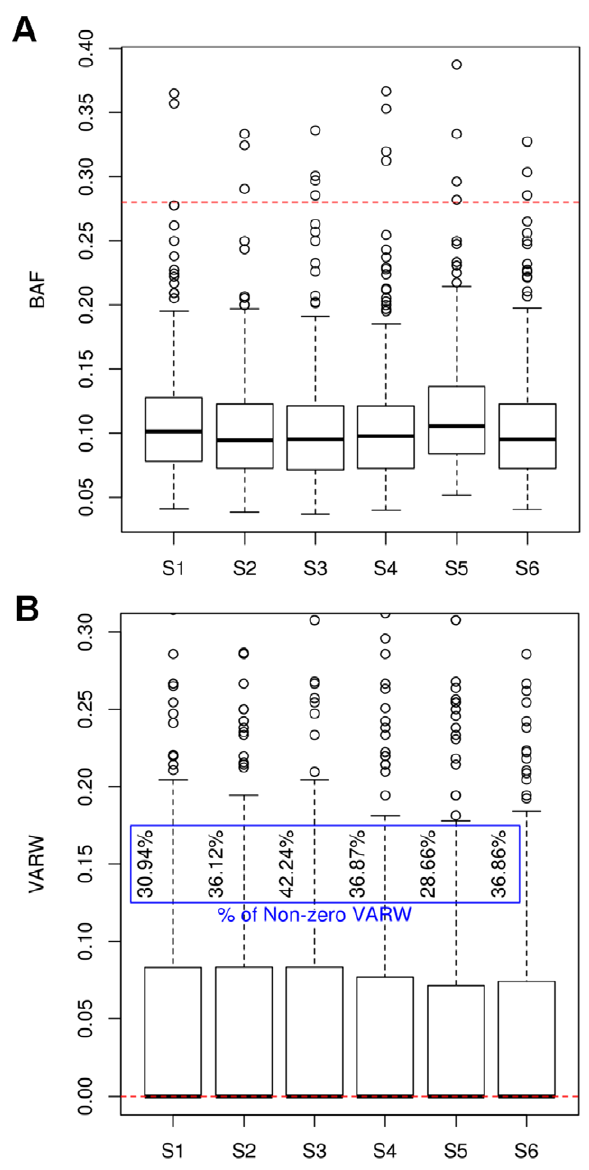
Figure 3. Distribution of BAFs and VARWs for indels derived from the BRCA1 and BRCA2 sequences of six patients. Boxplots for BAFs and VARWs of indels detected from PGM TM data of six patients were plotted. (A) The majority of BAFs were skewed towards the minimum. The dotted red line indicates the selected BAF th of 0.28. (B) The majority of the VARWs were equal to zero, indicated by a dotted red line. The percentages represent the proportion of non-zero VARWs.